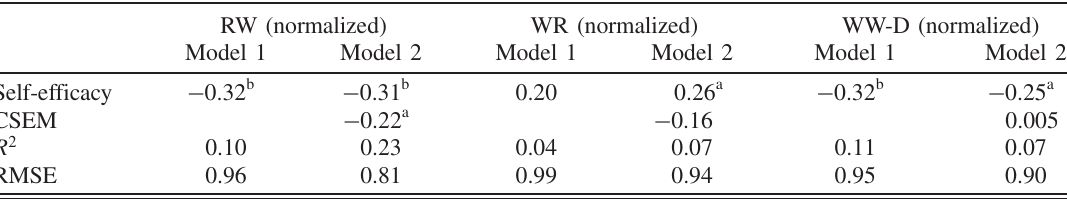
TABLE I. Standardized coefficients for linear regression models predicting proportion of responses switched from right to wrong (RW), wrong to right (WR), and wrong to a different wrong (WW-D), all normalized with respect to the first response. Model 1 controls for precourse student self-efficacy only, whereas Model 2 controls for both precourse student self-efficacy and CSEM scores.